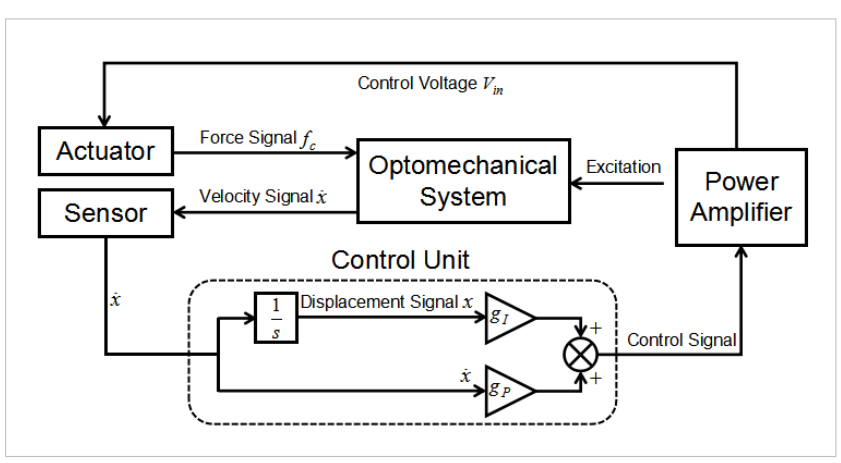
Figure 12. Optomechanical coupling active control system.